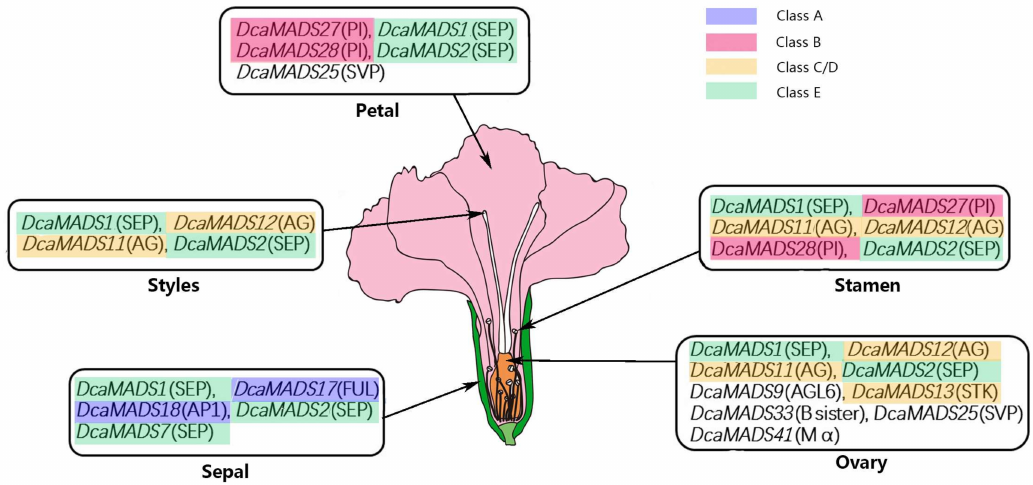
Figure 8. The high expression pattern of the DcaMADSs gene in carnation. The genes in rectangular boxes point to their expression being strongly detected, and the amount of expression decreased in